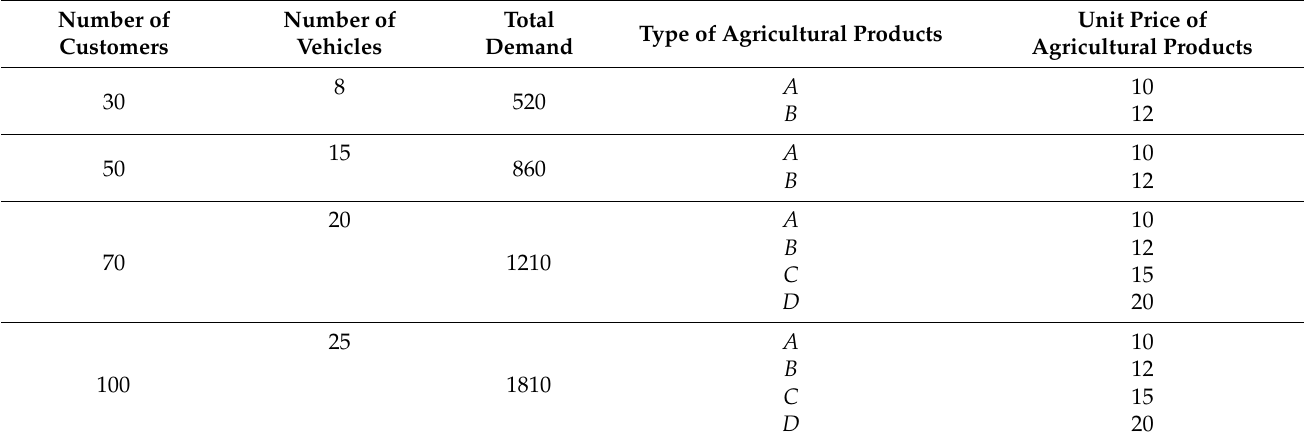
Table 2. Characteristics of datasets of different